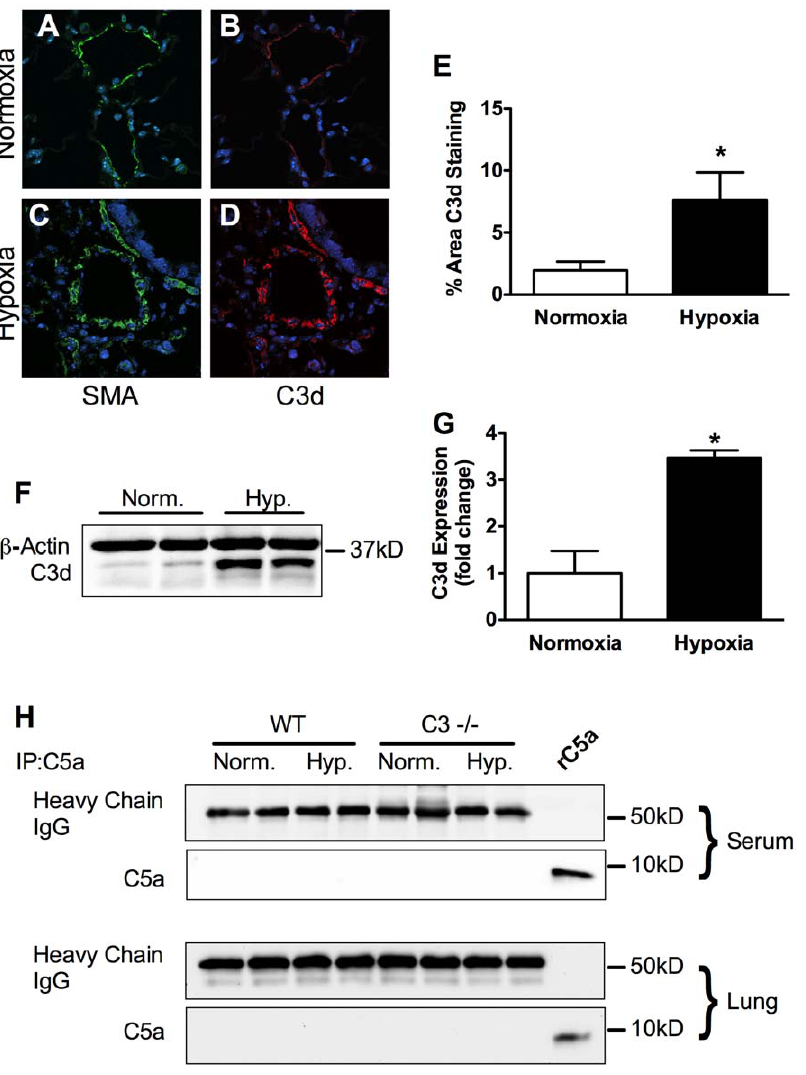
Figure 2. C3d deposition in chronic hypoxia-induced PH in mice. (A–D) Lungs from normoxic and hypoxic C57Bl/6J mice were stained with a -C3d and a -SMA antibody and counterstained with DAPI to detect nuclei(n=4). (E) Quantification of C3d staining in WT vs. C3 2 / 2 mice in normoxia and hypoxia. Bars represent the mean 6 SD (n=4). * P , 0.05. (F) Representative Western blot for C3d in normoxic vs. hypoxic C57Bl/6J mice. (G) Quantification of Western blots for C3d in normoxic vs. hypoxic mice. Bars represent the mean 6 SD (n=4). * P , 0.05. (H) C5a was immunoprecipitated from lung or plasma of normoxic and hypoxic C57Bl/6J mice and analyzed by Western blot (rC5a=recombinant mouse C5a).